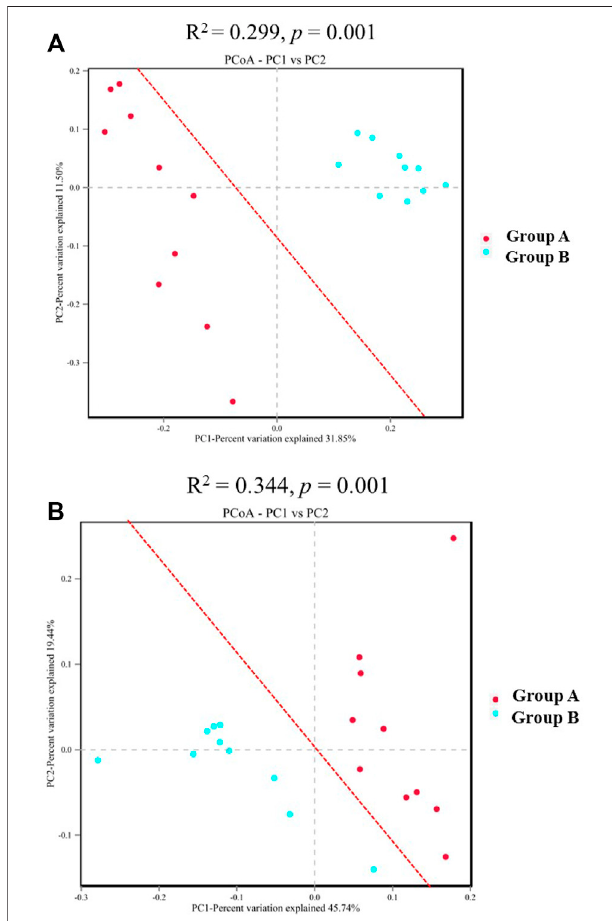
FIGURE 6 | Partial correspondence analysis ordinations of the sedimentary microbial community diversity. ( (A) unweighted (B) weighted). The R 2 obtained by the PERMANOVA indicates the degree of interpretation of the difference between different sedimentary groups. The larger the R 2 , the higheristhedegree ofinterpretation ofthedifference betweenthegroups, thegreateristhedifferencebetweenthegroups,andthehigheristhereliability of the test when the p value is less than